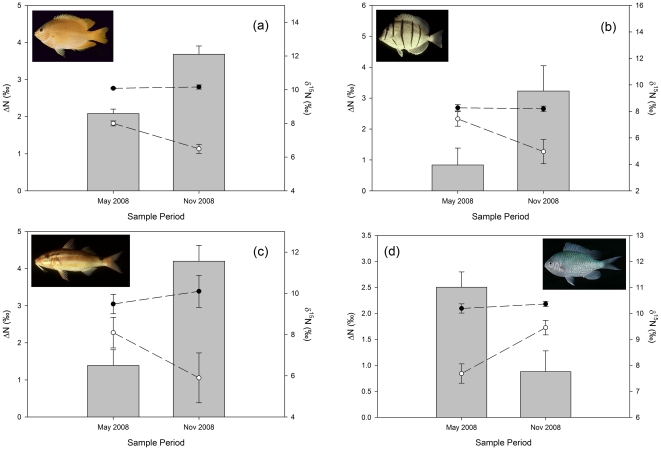
Seasonal variation in isotope discrimination factors.Plots show average nitrogen discrimination factors (ΔN, bars, left axis), tissue δ15N (solid circle, right axis) and gut δ15N (hollow circle, right axis) during May and Nov 2008 for (a) Pomacentrus moluccensis and (b) Acanthurus triostegus from 1 and 6a; (c) Parupeneus signatus sampled from 2, 3, 4, 6 and 7; and (d) Chromis viridis sampled from station 1. All ΔN and gut δ15N differences significant, no significant tissue δ15N differences or sample period×location interactions. See Figure 1 for locations. Fish images obtained from Froese & Pauly [39]; copyright J.E. Randall, 1997, used with permission. Data are mean ± s.e. (n as per Table 1).